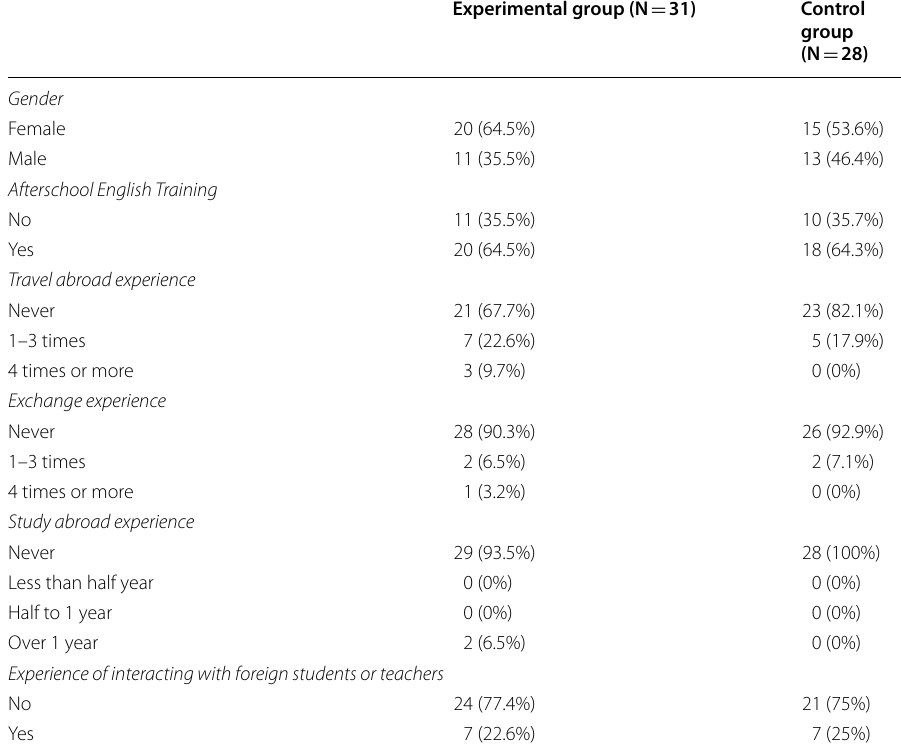
Table 1 Students’ general